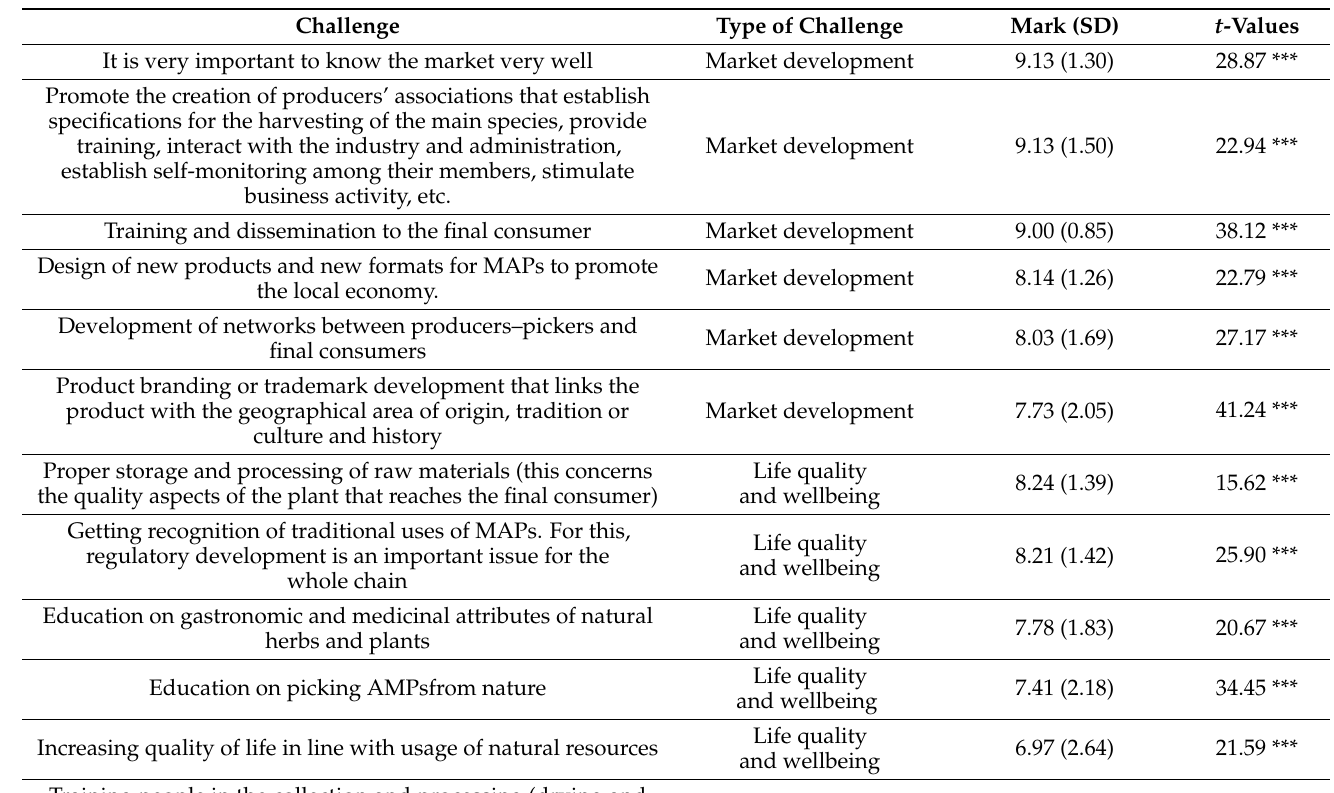
Table 2. Top ranked challenges of the MAPs sector identified by the panellists at the end of the second Delphi